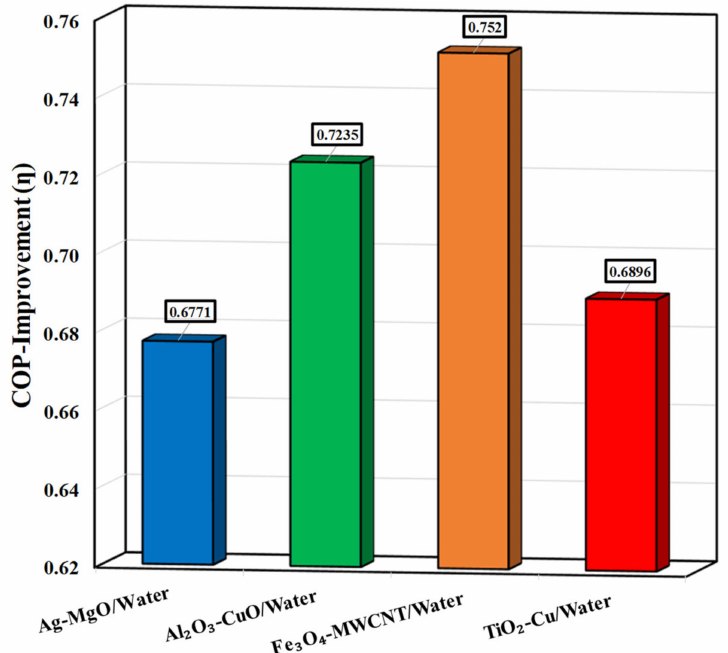
Figure 8. Coefficient of performance (COP)-improvement for various hybrid nanofluids at φ = 0.15 and Re = 3200.